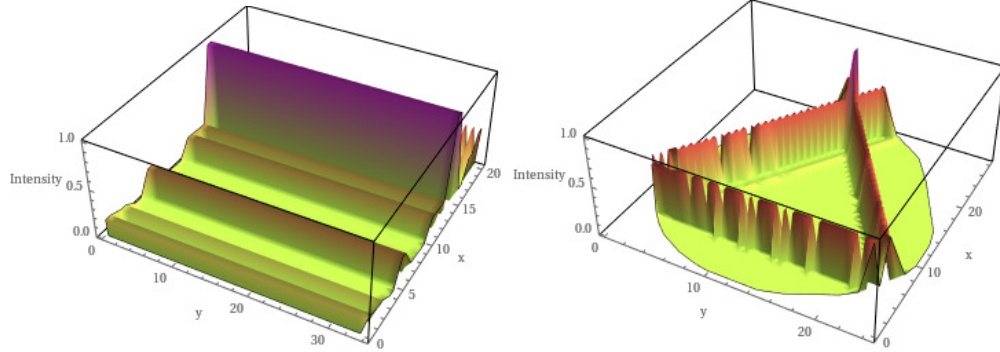
Figure 15. Selected striped wave functions (intensity | c ( κ , κ (cid:48) ) ( x , y ) | 2 shown) of the honeycomb lattices with rectangular ( left ) and Africa ( right )